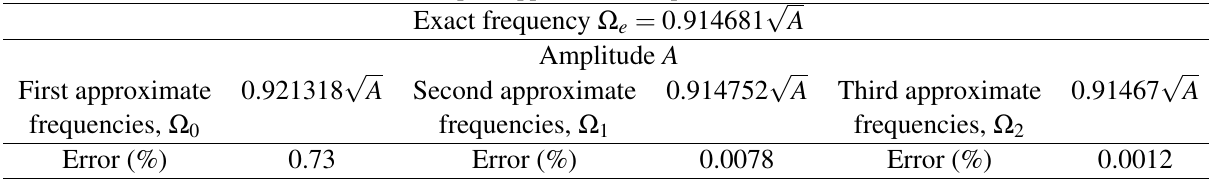
Table 1 Adopted approximate frequencies of ¨ x + x 2 = 0.